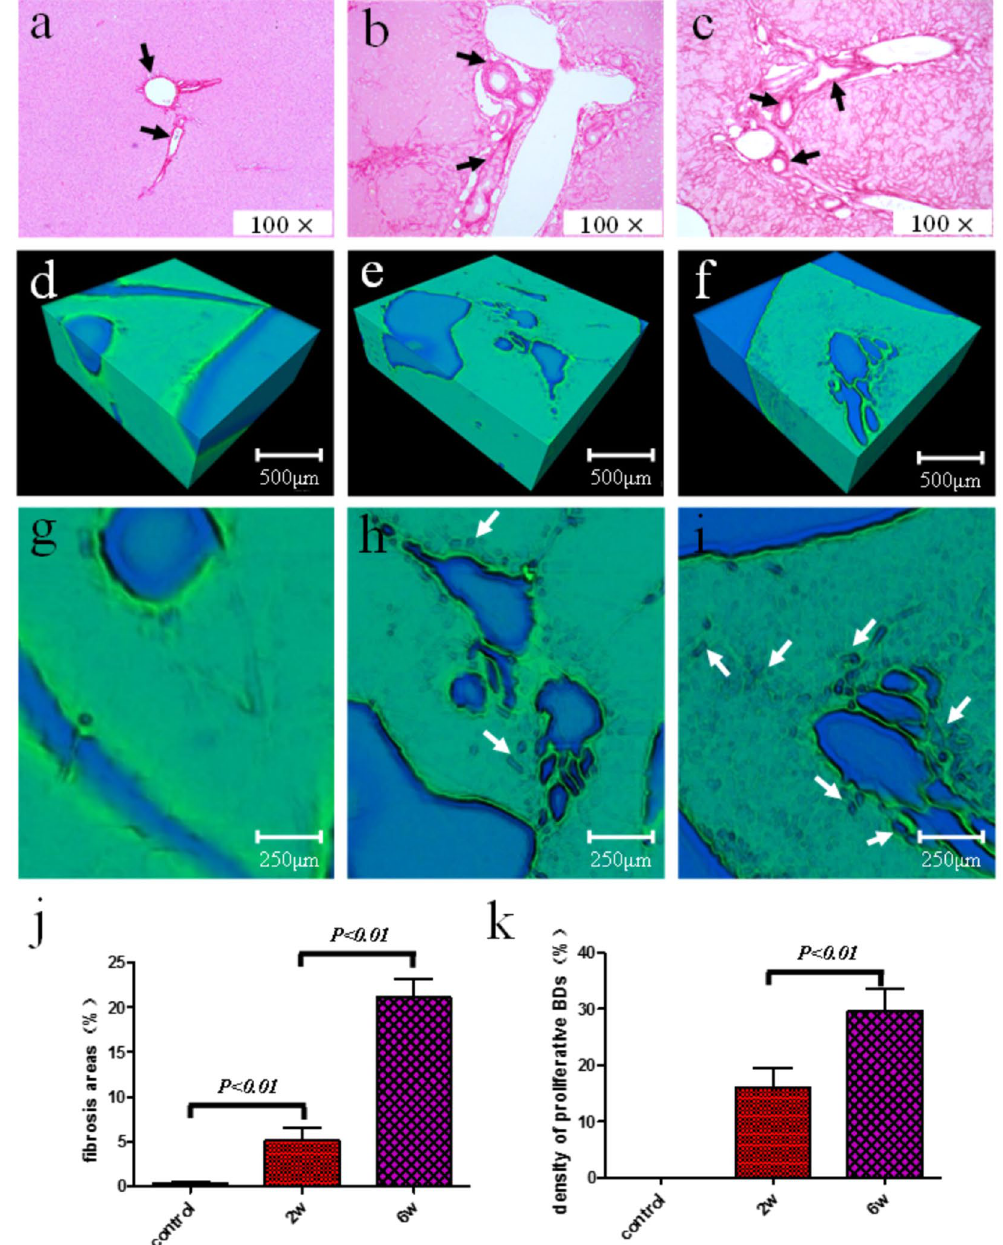
Figure 3. Illustration and quantification of fibrosis and proliferative BDs in liver fibrosis progression. Histological sections stained by Sirius Red showing representative images of the control group, the 2-week and 6-week post-BDL groups are shown in ( a ) to ( c ). The volume rendering images of three groups are shown in ( d ) to ( f ). The amplified images of the upper surface in ( d ), ( e ) and ( f ) are provided in ( g ) to ( i ), respectively. Fibrosis area ( j ) and the density of proliferative BDs ( k ) are summarized and shown for different groups. The black and white arrows indicate the fibrous bands and proliferative BDs, respectively. For all comparisons, P was less than 0.01. Note that the ductular proliferations are not detected in the livers of the control